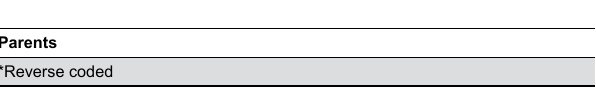
Table 1. Statements used for measuring levels of closeness with parents and with peers, and depressive